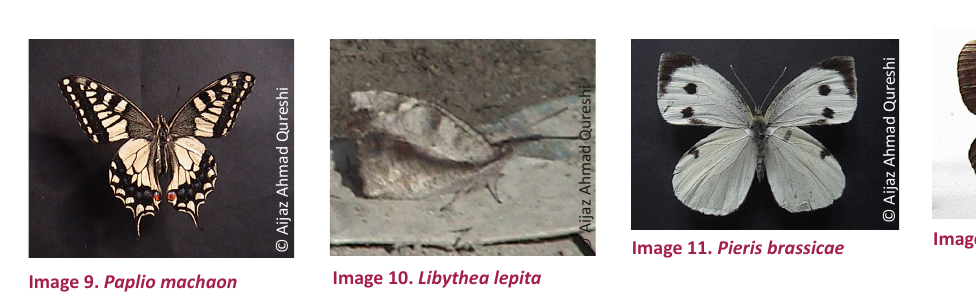
Image 14. Neptis sappho (underside)